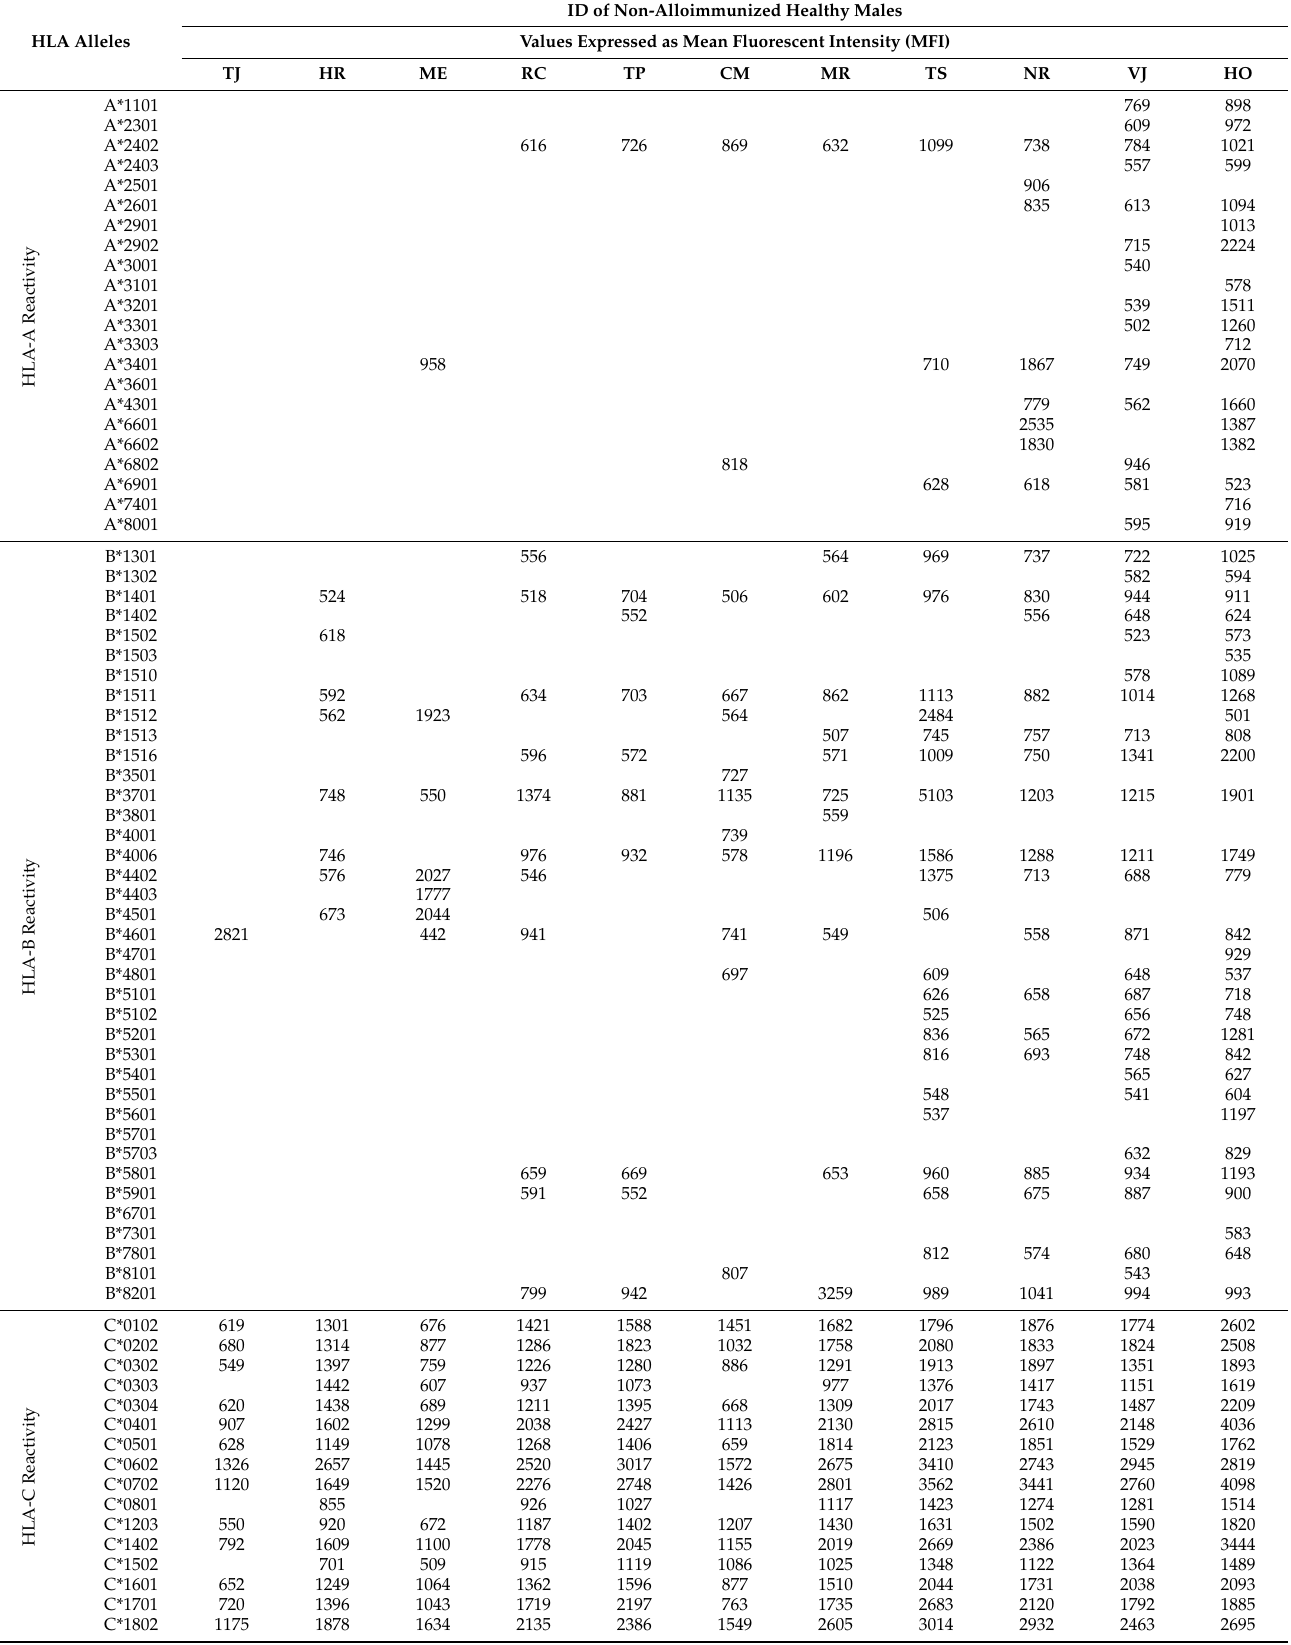
Table 11. HLA-Ia reactivity of antibodies of non-alloimmunized